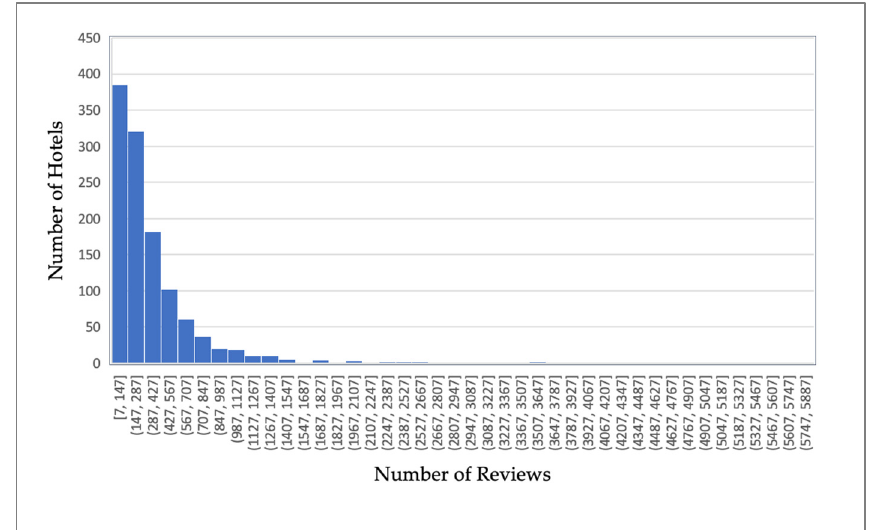
Figure 3. Dataset distribution according to the number of reviews per hotel.